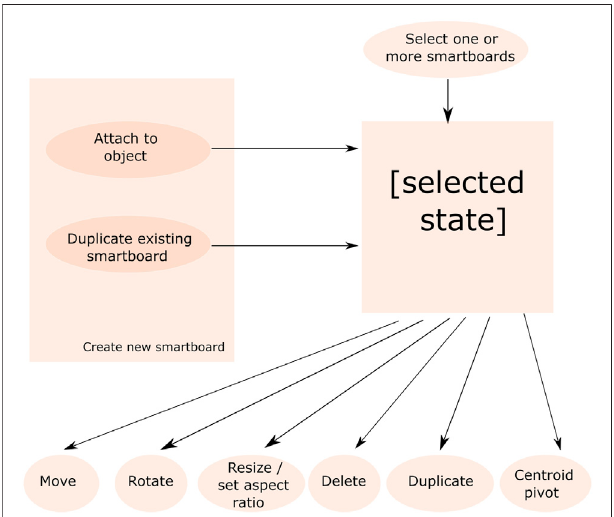
FIGURE 3| Work fl owprocess behind proposed editing operations. The key idea behind the work fl ow is that once one or more smartboards are selected, they can be moved, rotated, resized, deleted, duplicated or rotated aroundtheircommoncentroid.Smartboardscanbeselecteddirectly,or onewillbeselectedifitiscreatedanew(either via duplicationorbyattachment to an